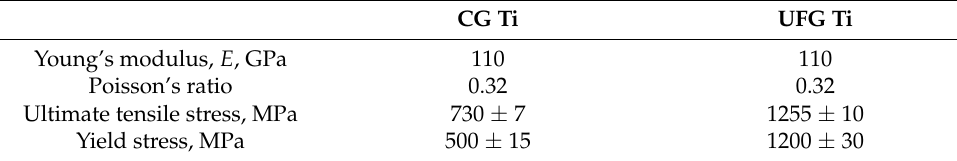
Table 1. Mechanical parameters of CG and UFG Ti Grade 4.